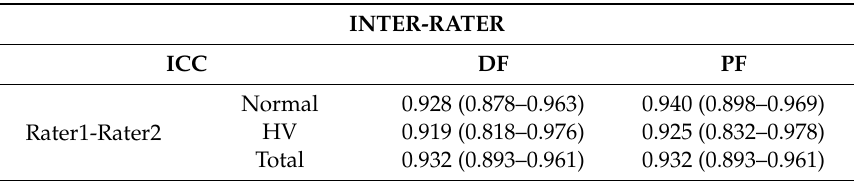
Table 4. Inter-rater reliability (ICC) from raters 1and 2 in day 1 for each first ray movement measured with the new device.